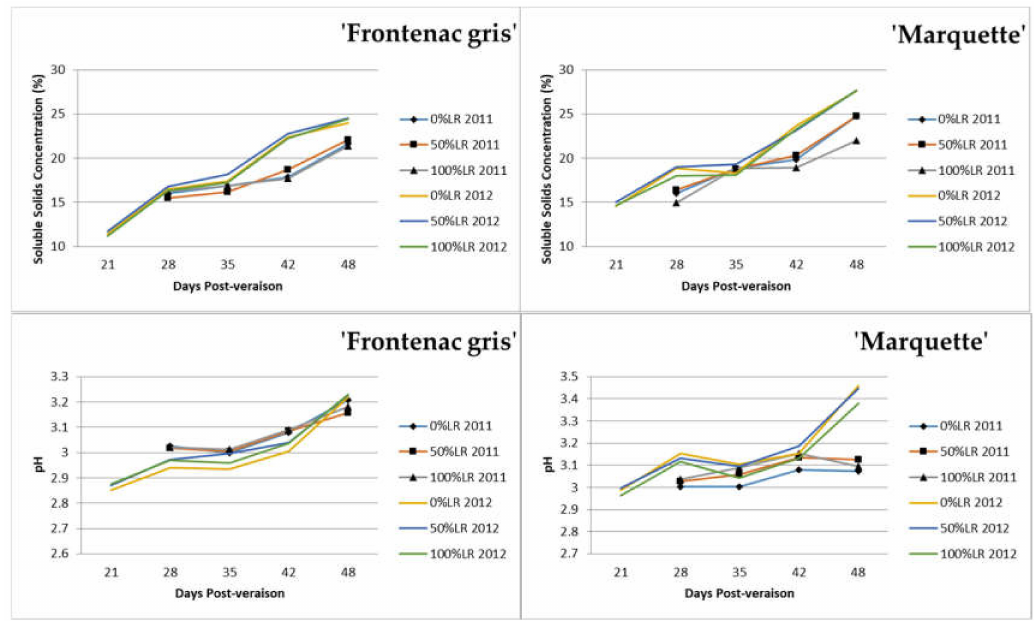
Figure 4. Weekly fruit sampling to determine soluble solid concentration and pH as parameters of fruit maturity for two V. riparia -based cultivars averaged over the number of retained primary buds and locations; z Abbreviation LR = percentage of fruit-zone leaves removed.